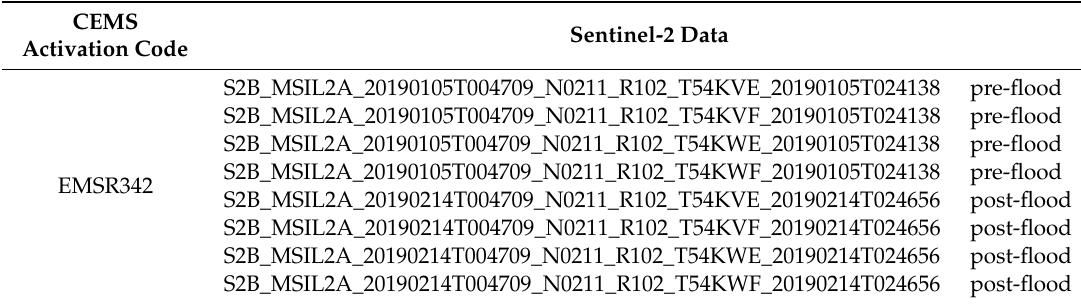
Table 3. S2-L2A tiles used in this study for flood mapping.